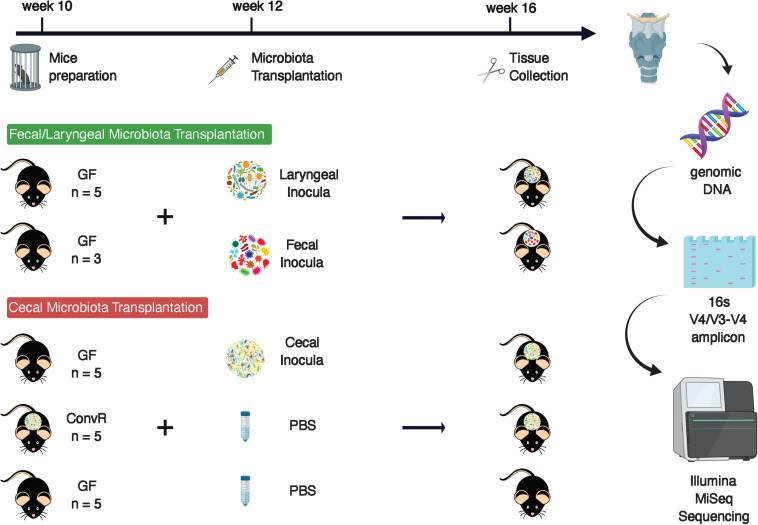
Experimental design.